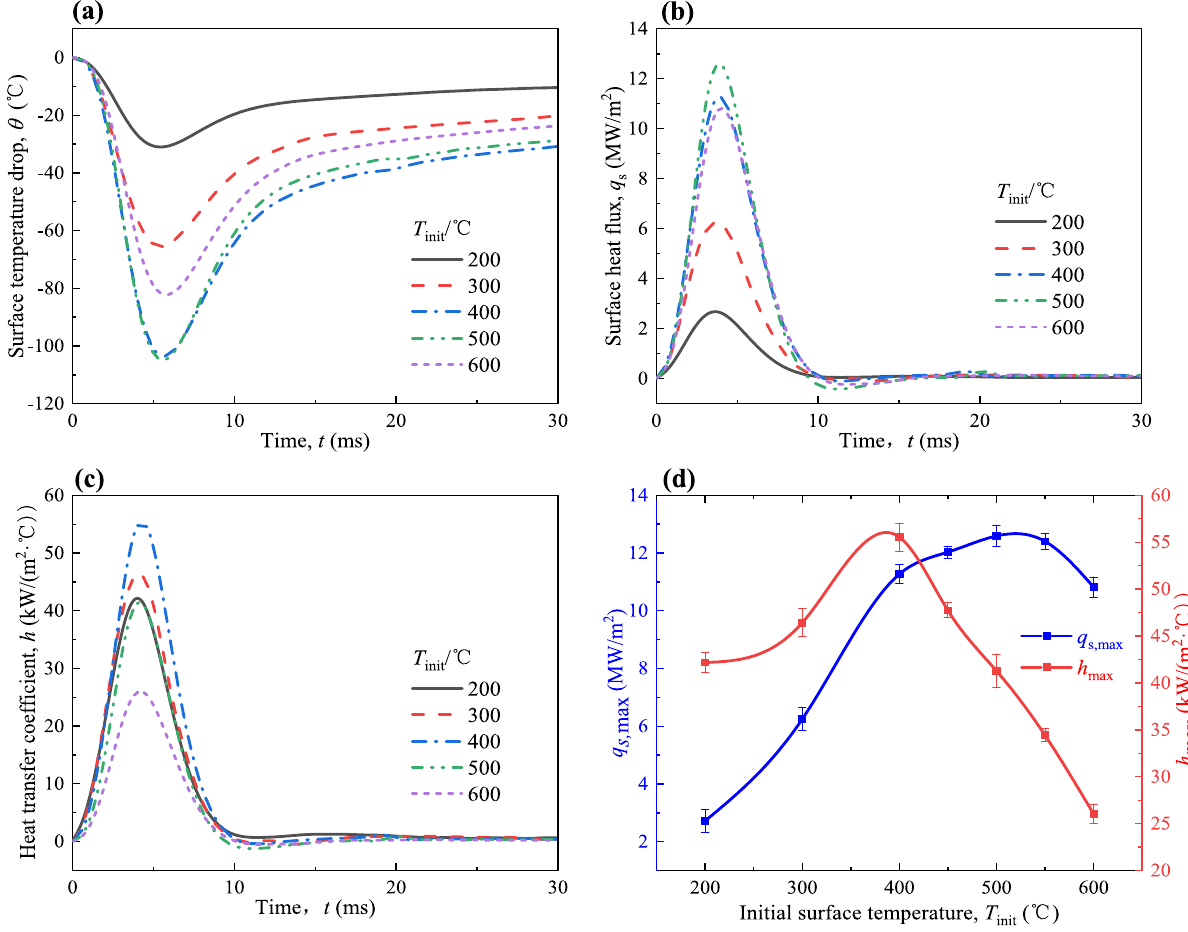
Figure 4. Variations of ( a ) θ , ( b ) q s , ( c ) h , and ( d ) q s,max and h max at different T init with spray-wall impingement for P inj = 160 MPa and T amb = 80